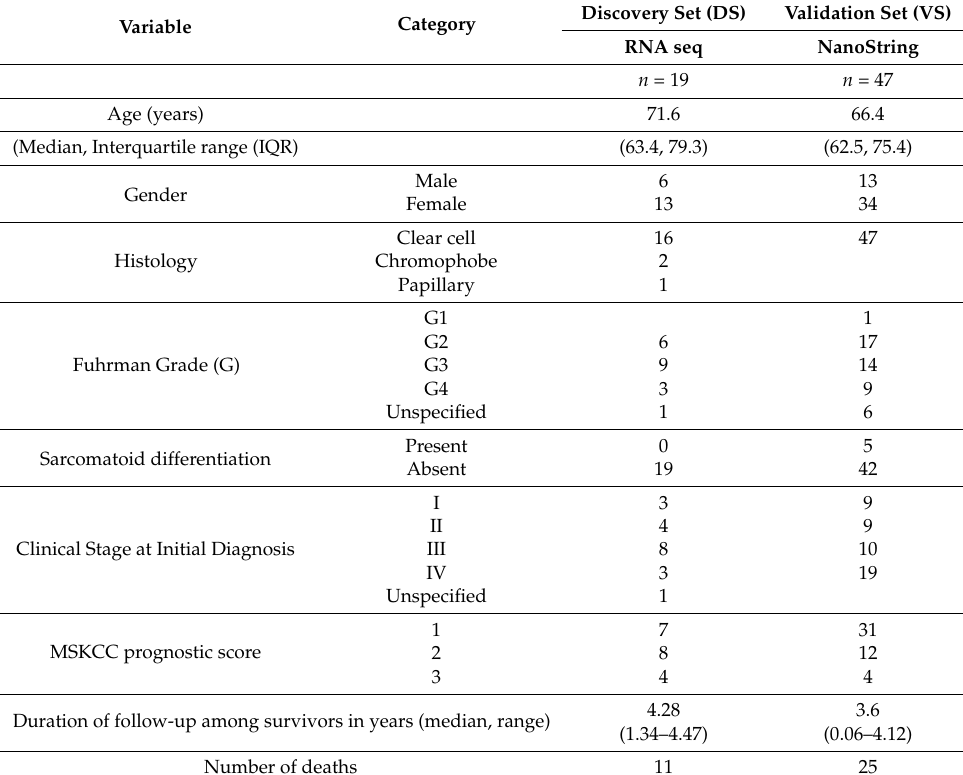
Table 1. Clinical and pathologic patient